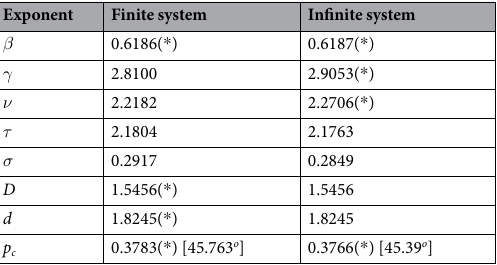
Exponent Finite system